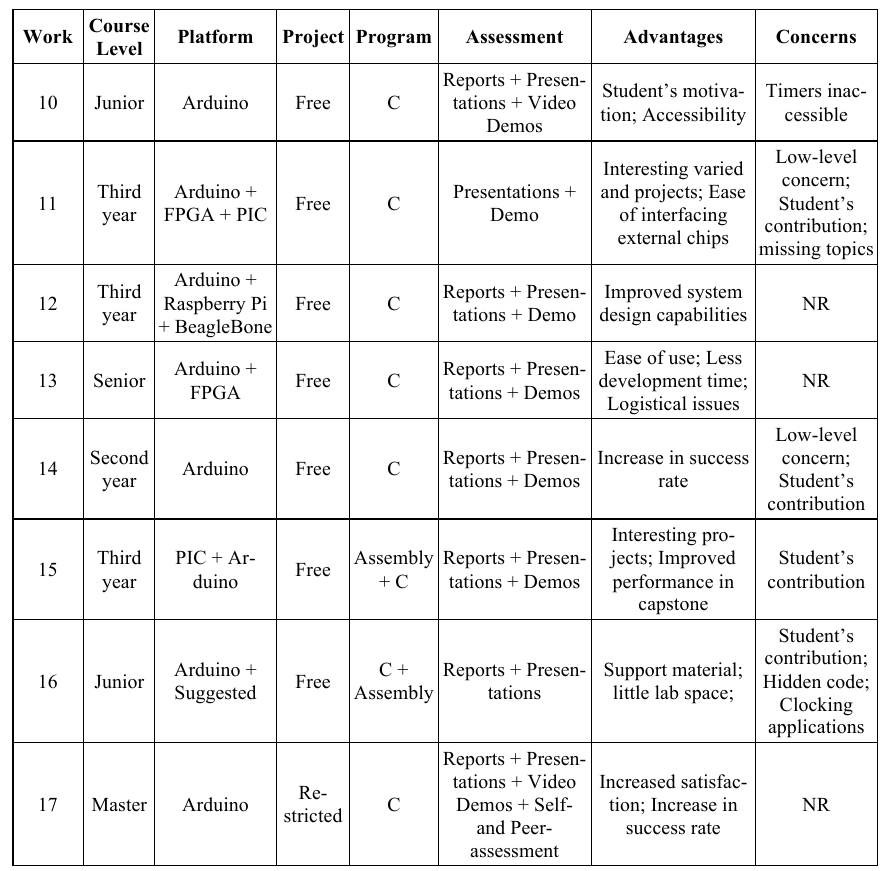
Table 1. Arduino integration methodologies